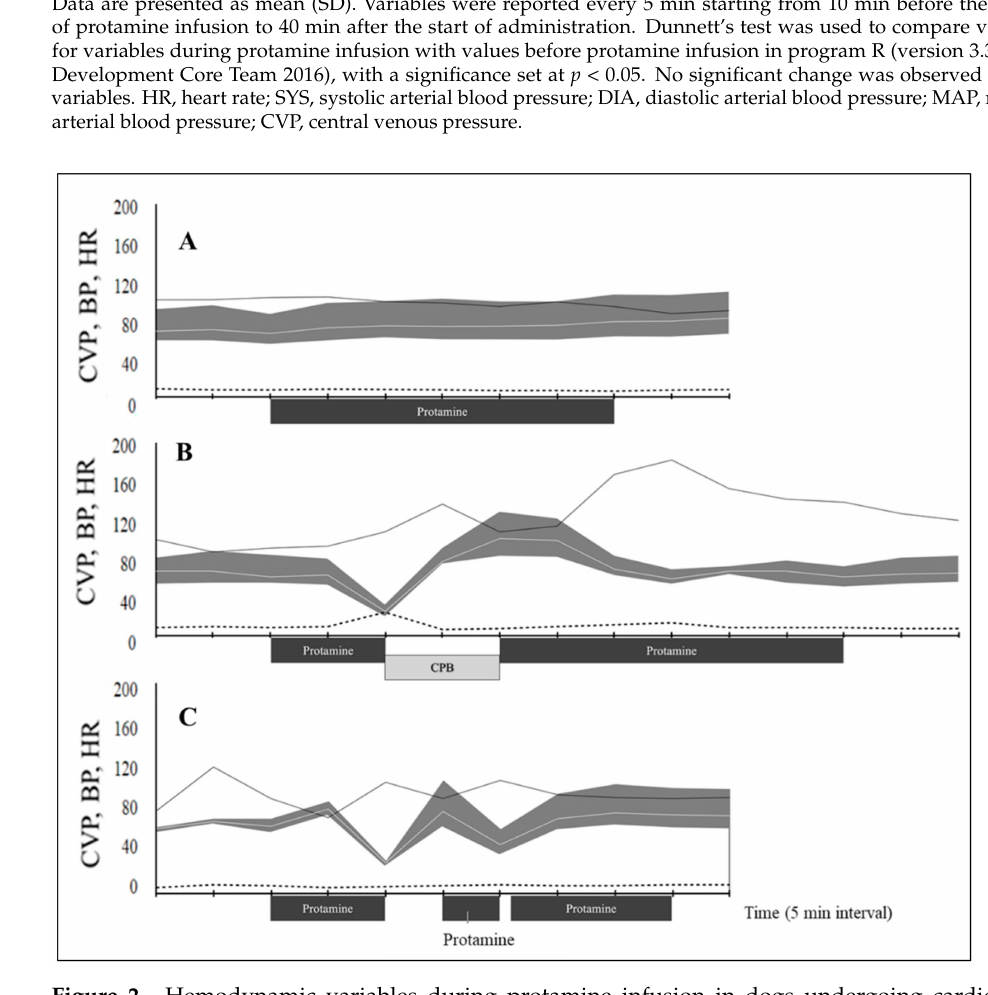
Figure 2. Hemodynamic variables during protamine infusion in dogs undergoing cardiopul- monary bypass for mitral valve repair. ( A ) Mean values for 12 dogs without hypotension. Dog number 1 ( B ) and dog number 2 ( C ) show protamine shock. The blood pressure (BP, mmHg) is presented as a gray shading curve. Mean arterial pressure (white line within grey shading); the upper and lower limits of the shading curve are systolic and diastolic pressures); heart rate (HR, bpm; solid black line); and central venous pressure (CVP, mmHg; dashed line) recorded every 5 min from 10 min before the start of protamine administration. CPB, cardiopulmonary